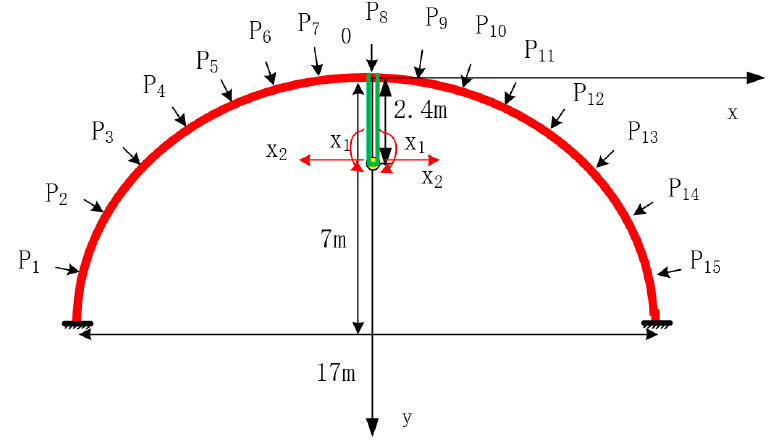
Figure 3. Computational analysis model.